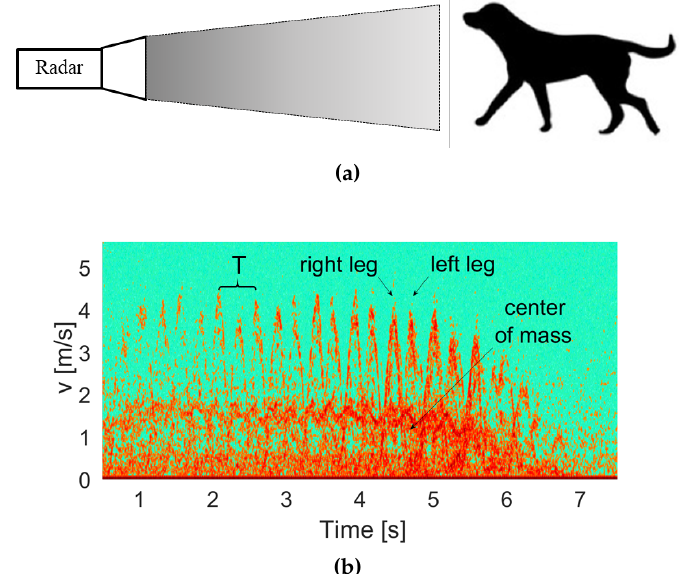
Figure 10. ( a ) Illustration of the detection of a walking dog. ( b ) Dog motion